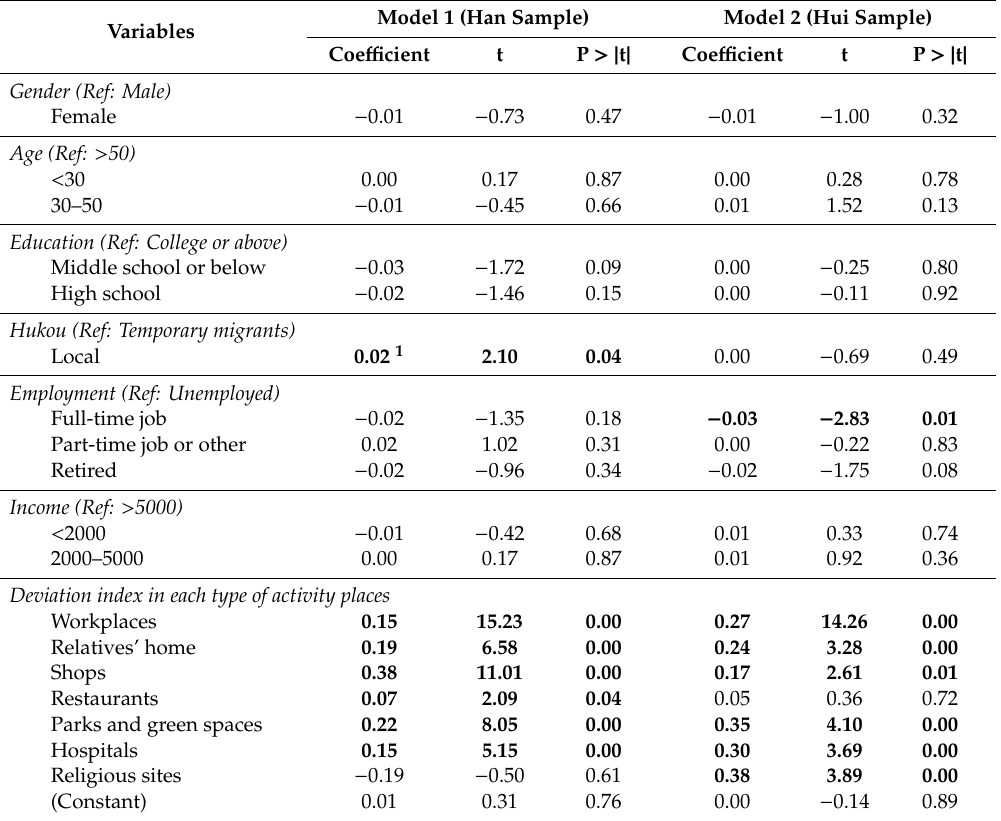
Table 4. Results of one-limit censored Tobit